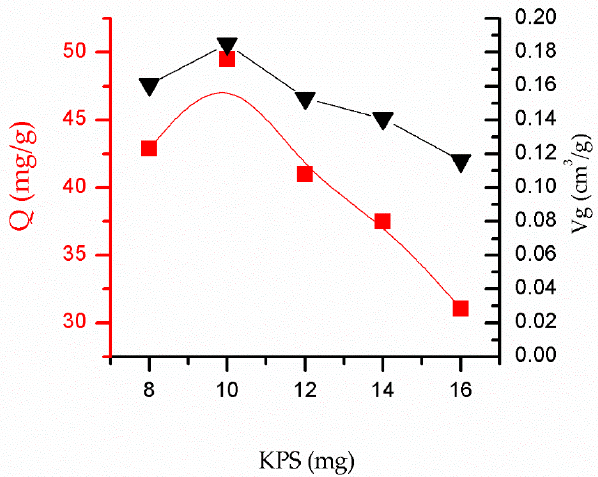
Figure 8. The influence of the initiator dosage on the adsorption performance of SSO-MIPs and pore volume.